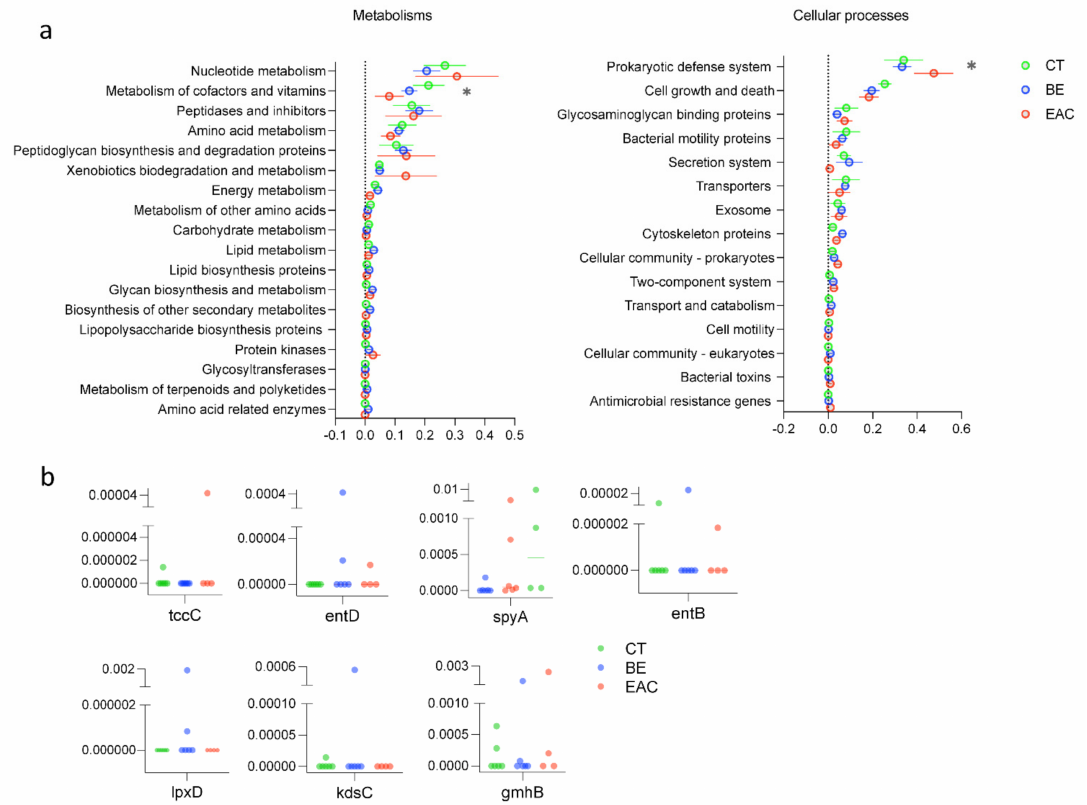
Figure 3. Viral functional traits. ( a ) The relative abundance of different functional traits in viral sequences; ( b ) The relative abundance of genes encoding four different bacterial toxins with higher abundance in BE and EAC samples compared with CT on the top, and genes encoding the LPS biosynthesis proteins on the bottom. Error bars indicate the average ± SE. Statistical significance was determined by two–way analysis of variance [ANOVA], Tukey’s post hoc test, asterisk indicates p <